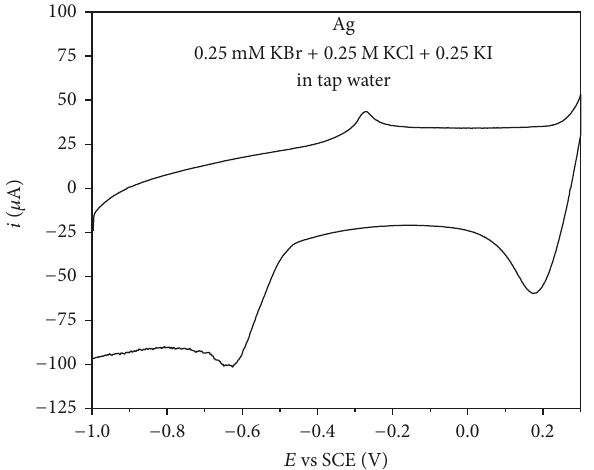
Figure 7: CV of Ag catalyst in 0.25 mM KBr + 0.25 mM KCl + 0.25 mM KI in tap water recorded at scan rate of 100 mVs −1 .